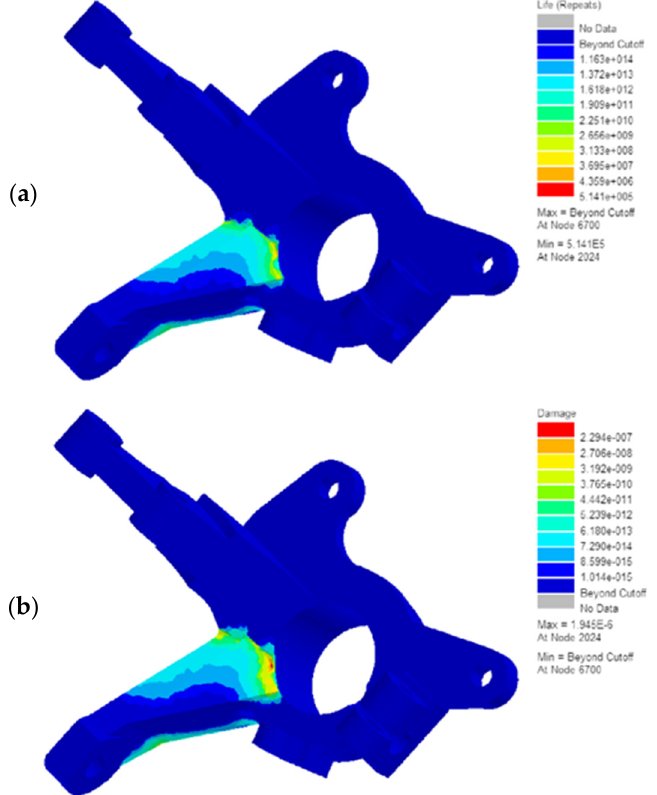
Figure 11. The results of fatigue analysis considering actual loading conditions, including ( a ) axial fatigue life contour of cast iron steering knuckle subjected to the different maneuvers and ( b ) fatigue damage contour of cast iron steering knuckle under axial variable amplitude loading caused by different maneuvers. Table 5. Comparison of fatigue life prediction by utilizing different methodologies and experiment